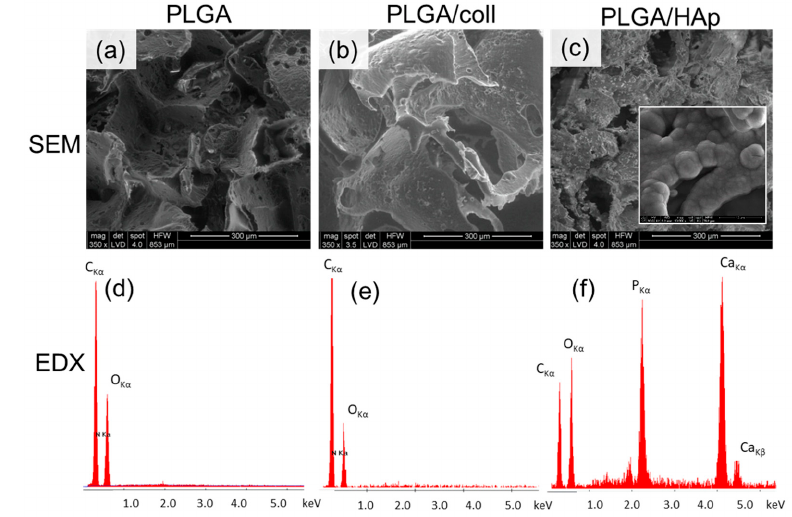
Figure 1. Microstructure by scanning electron microscopy (SEM) ( a – c ) and elemental analysis by energy dispersive X-ray spectroscopy (EDX) ( d – f ) of the sca ff olds: Poly( l -lactide- co -glycolide) (PLGA) ( a , d ), Poly( l -lactide- co -glycolide) modified with collagen type I (PLGA / coll) ( b , e ), and Poly( l -lactide- co -glycolide) modified with hydroxyapatite (PLGA / HAp) ( c , f ). Insert in